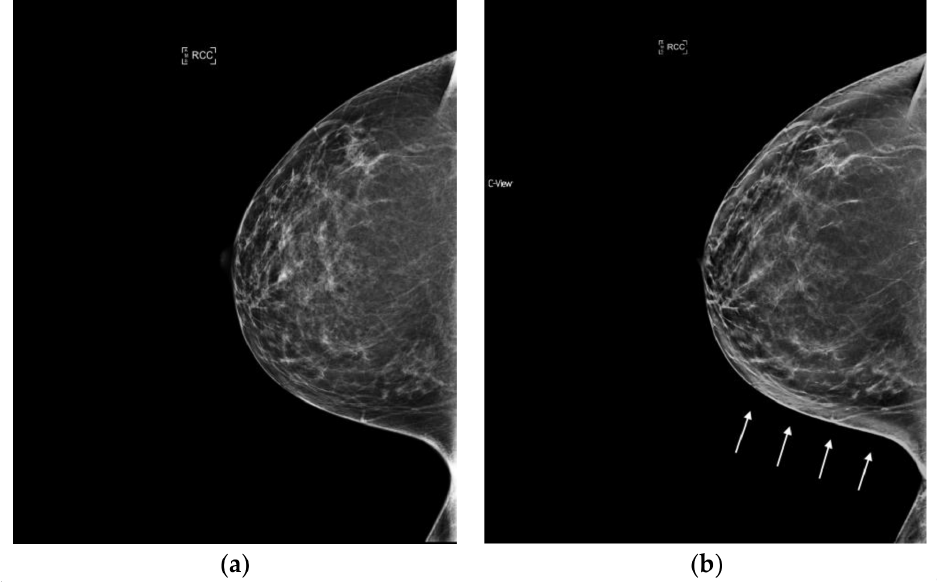
Figure 6. Bright band artifact (indicated by arrows) can be seen along the curvature of the medial